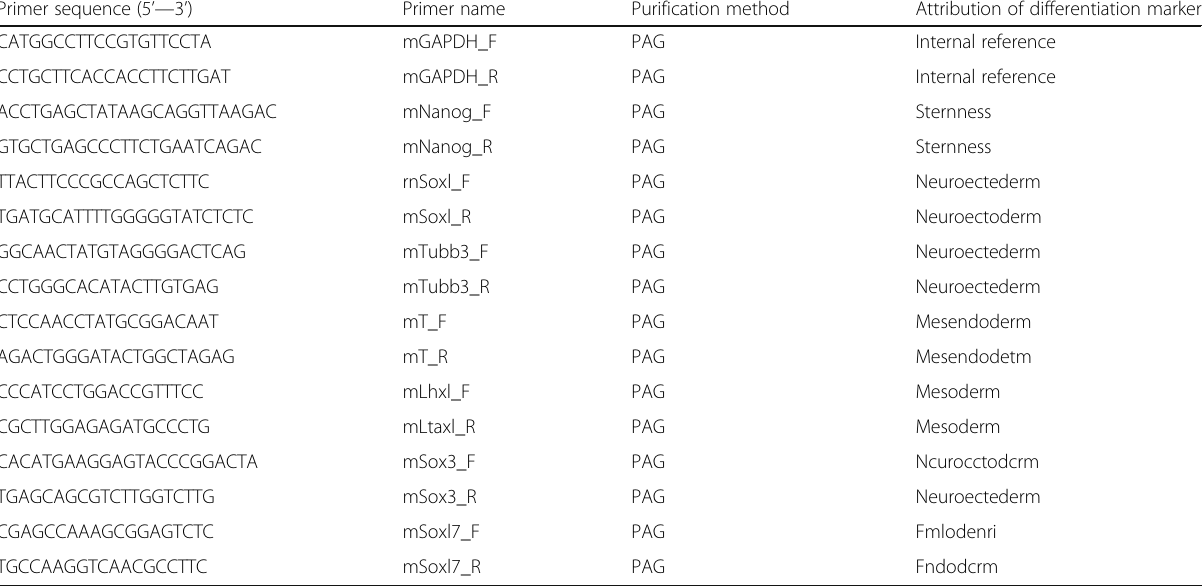
Table 1 Primer sequences of the germ layer differentiation markers for qPCR assay Primer sequence (5 ’— 3 ’